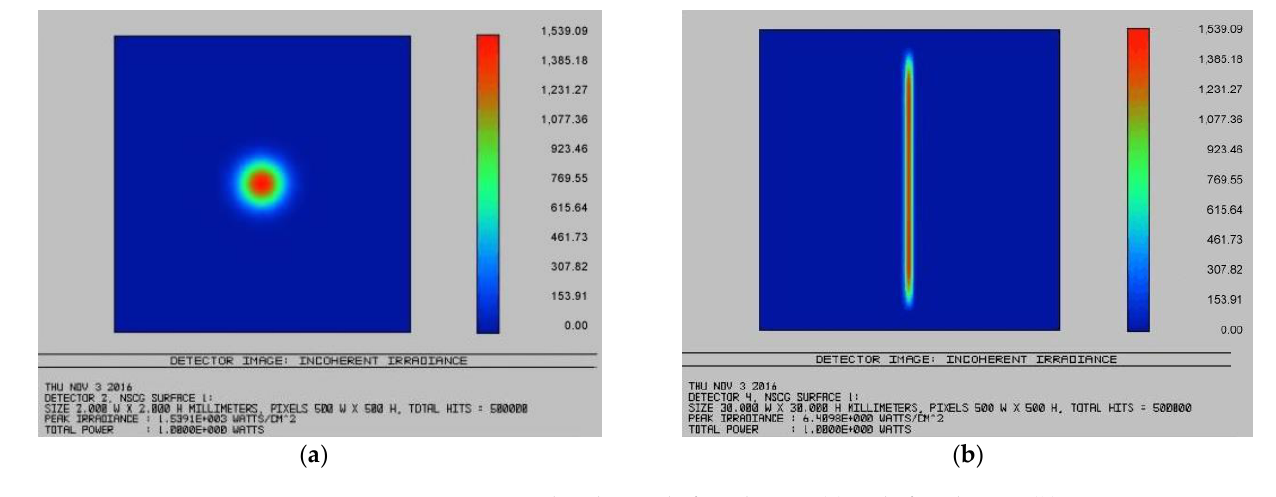
Figure 3. Laser power distribution before shaping ( a ) and after shaping ( b ).